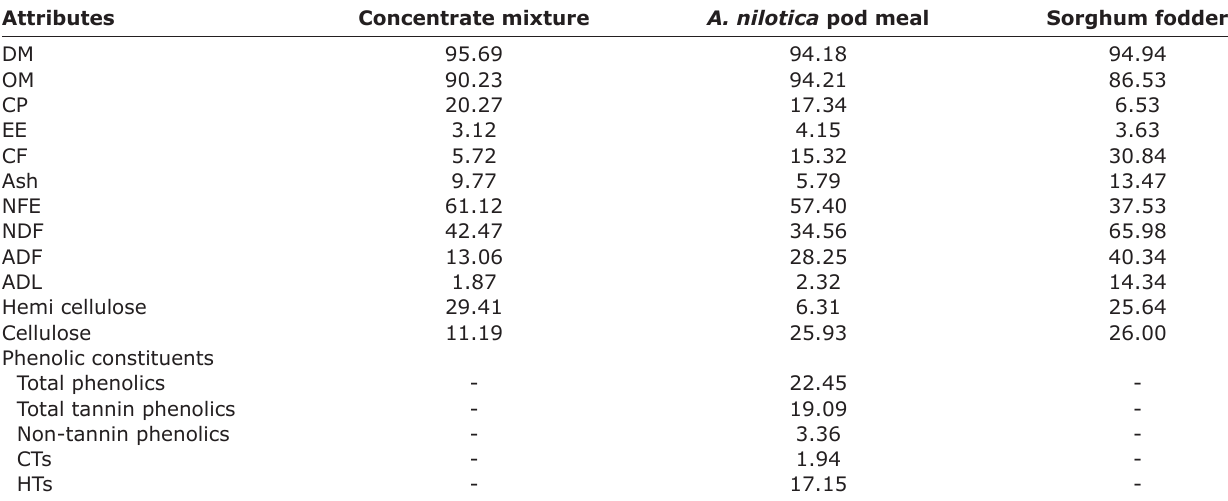
Table-1: Chemical composition (%, DM) of feed stuffs used in the study. Attributes Concentrate